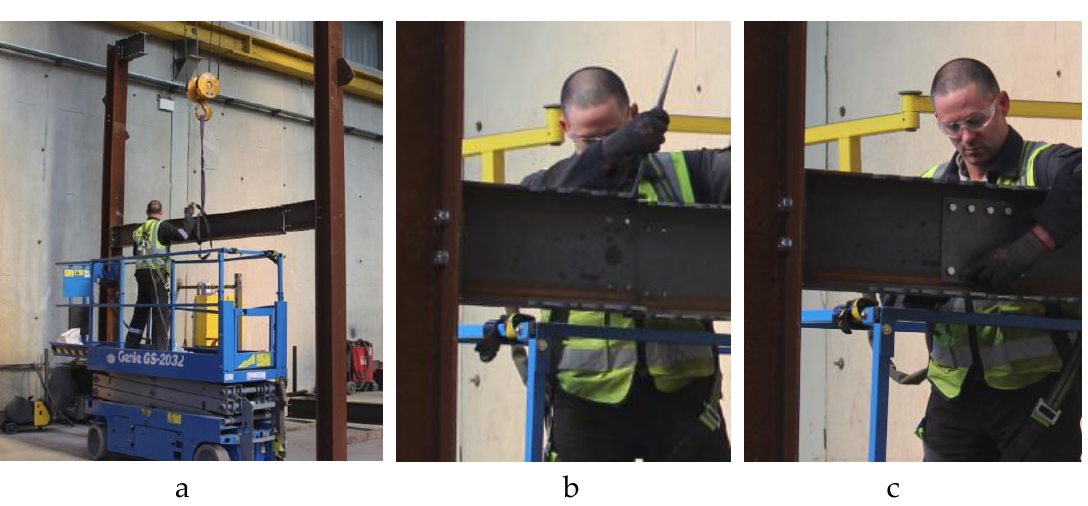
Figure 16. Initial steps of frame erection: ( a ) tightening of column holding down bolts; ( b ) overall view of the frame stub beams.